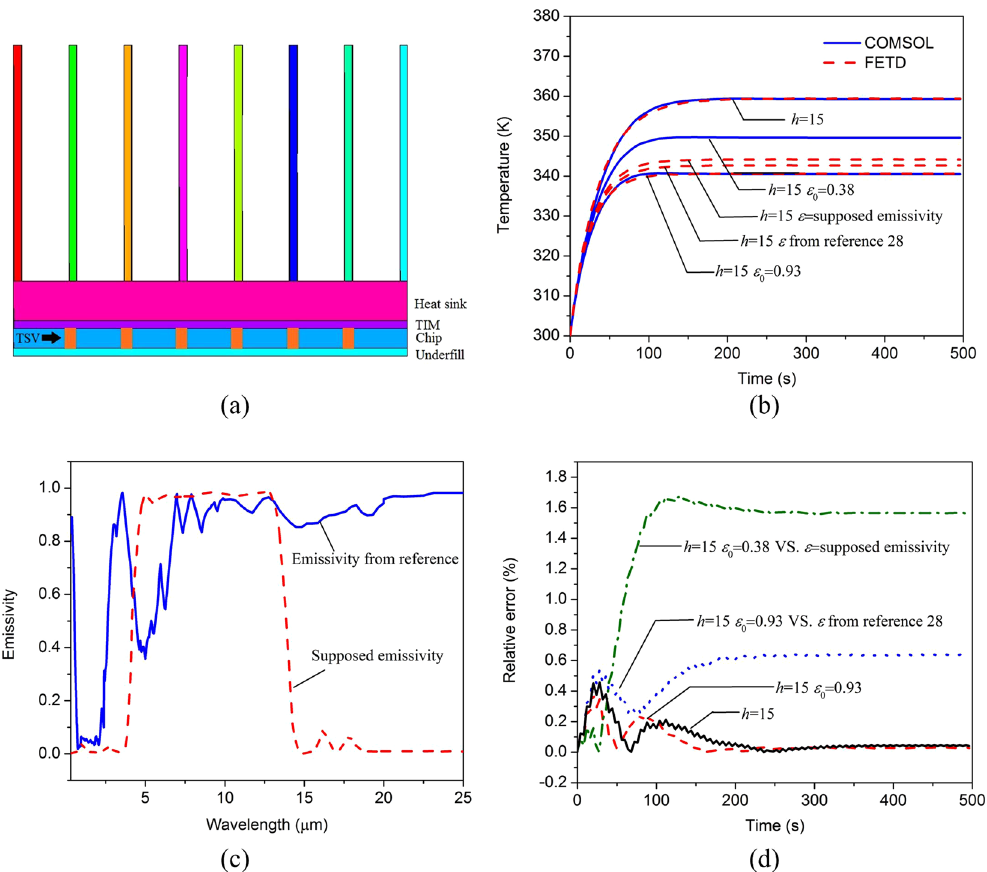
Figure 6. ( a ) Cross-section view of the 3D IC package model, ( b ) the temporal temperature at the observation point obtained by the proposed method and the COMSOL software, ( c ) the supposed emissivity and the emissivity in reference 28 , ( d ) the relative errors between the proposed method and COMSOL software.